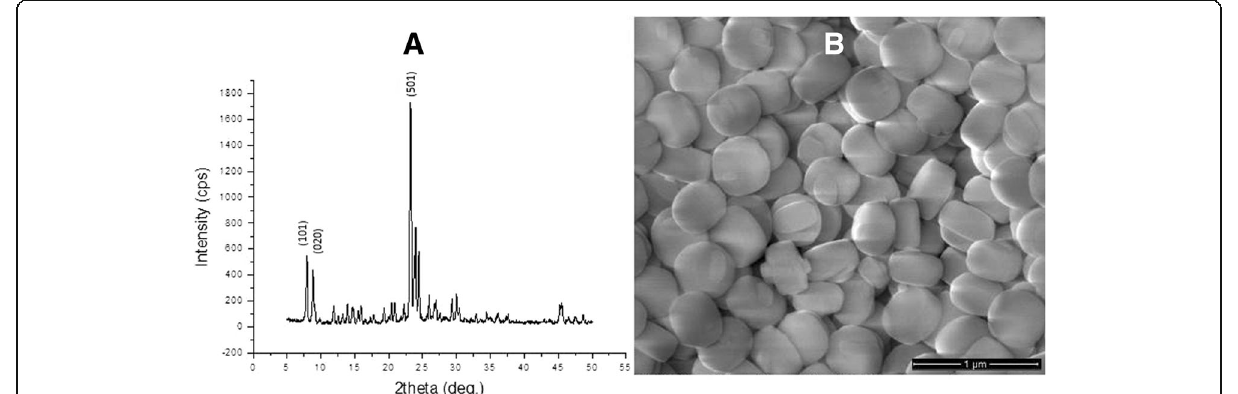
Fig. 1 XRD spectrum ( a ) and SEM image ( b ) of synthesized silicalite